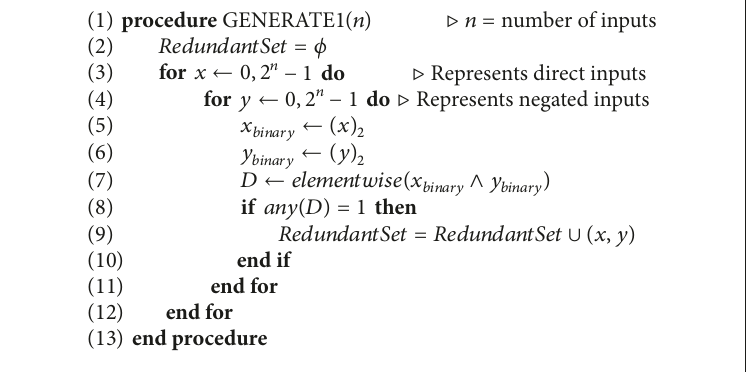
Algorithm 1: Redundant set generation for Pandit-Plot.